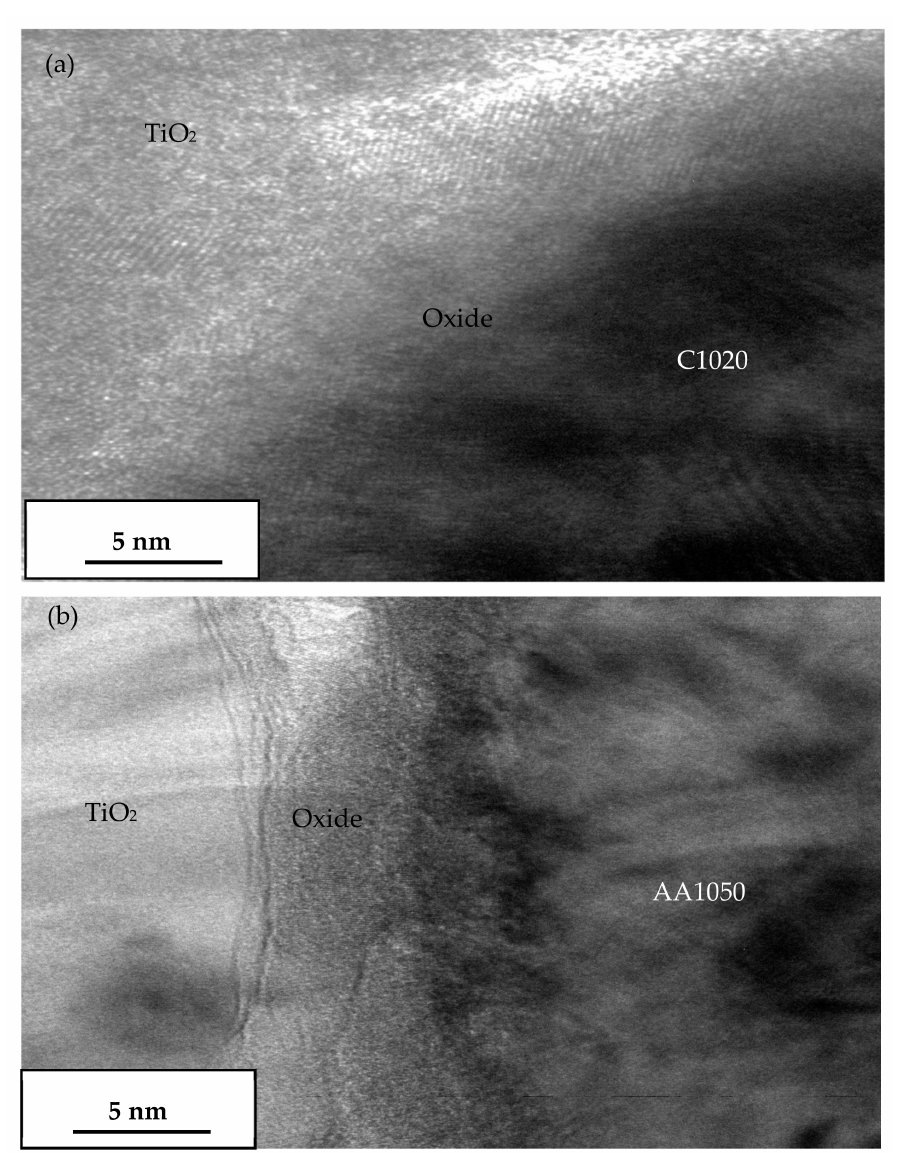
Figure 12. Remaining oxide films at the interface between the TiO 2 particle and ( a ) C1020 and ( b ) AA1050 annealed at 400 ◦